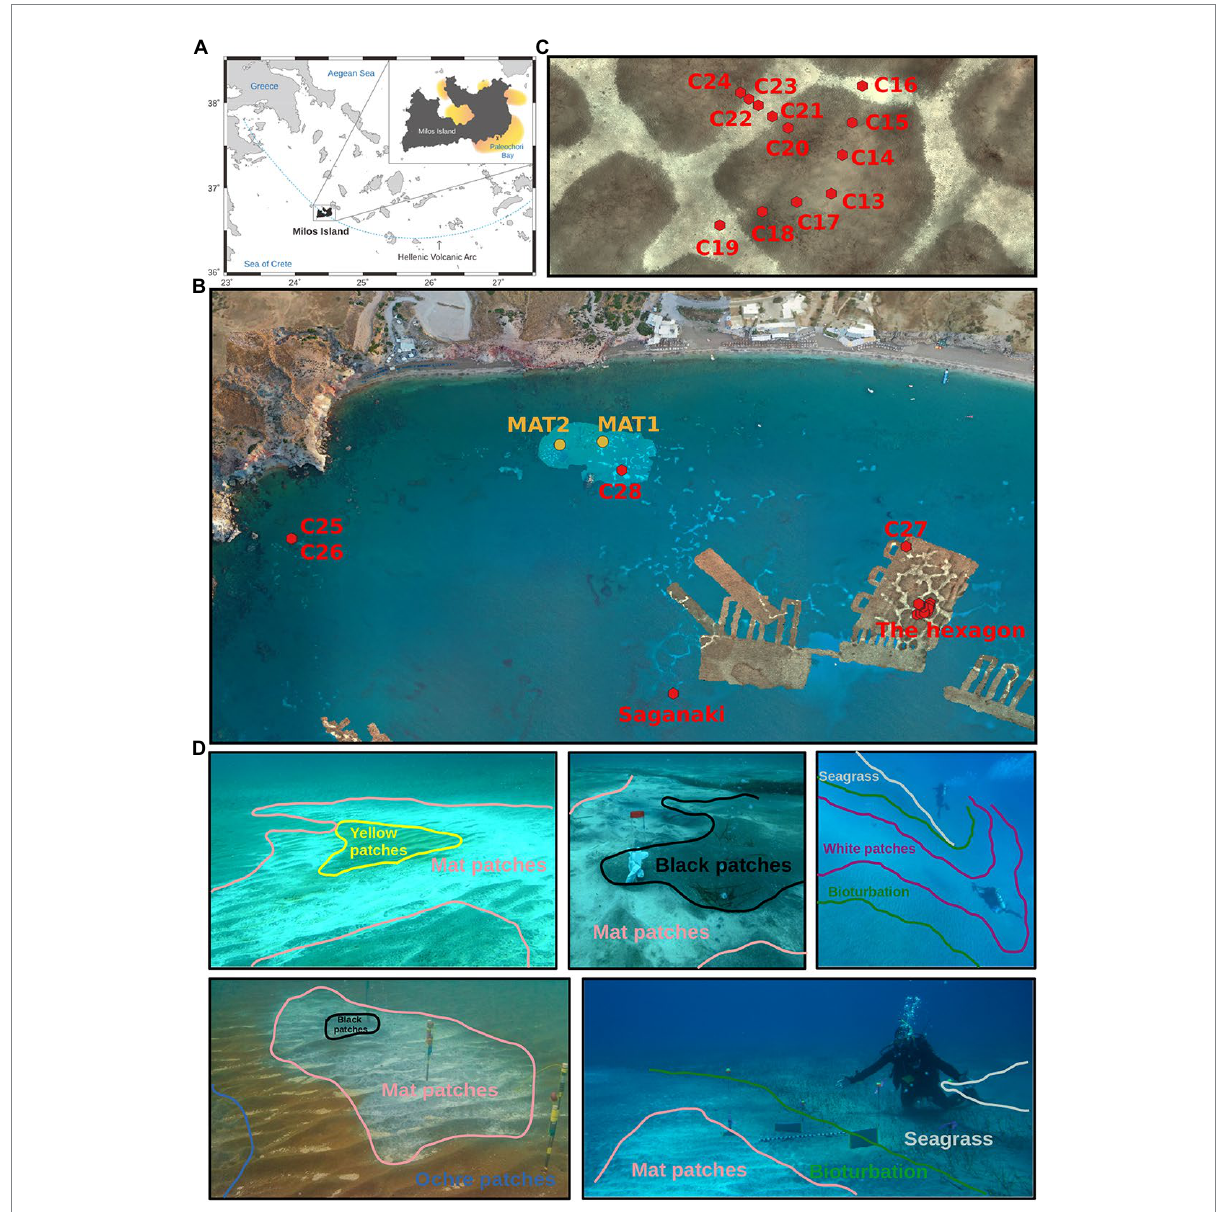
FIGURE 1 Map and photographies of the sampling locations. (A) Localization of Milos and Paleochori Bay. (B) Localization of the cores taken in Paleochori Bay. (C) Zoom into the location of “The hexagon.” (D) Photographies of the various types of seafloor investigated here. The lower right picture represents the Saganaki vent field. The colors used are consistent throughout the figures, with light blue/grey for seagrass patches, green for bioturbation, blue for ochre patches, dark pink for white patches, salmon for mat patches, black for black patches, and yellow for yellow patches. See Puzenat et al. (2021) for details on the publicly available AUV and drone background photomosaics in (B,C) (Martelat et al., 2019; Puzenat et al.,